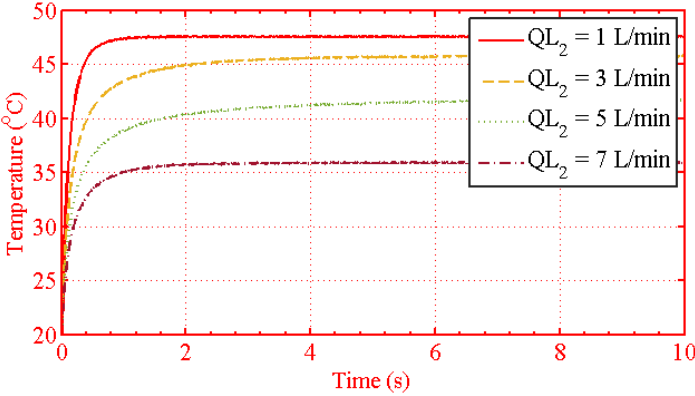
Figure 14. The output temperature in cold fluid with QL 1 = 5